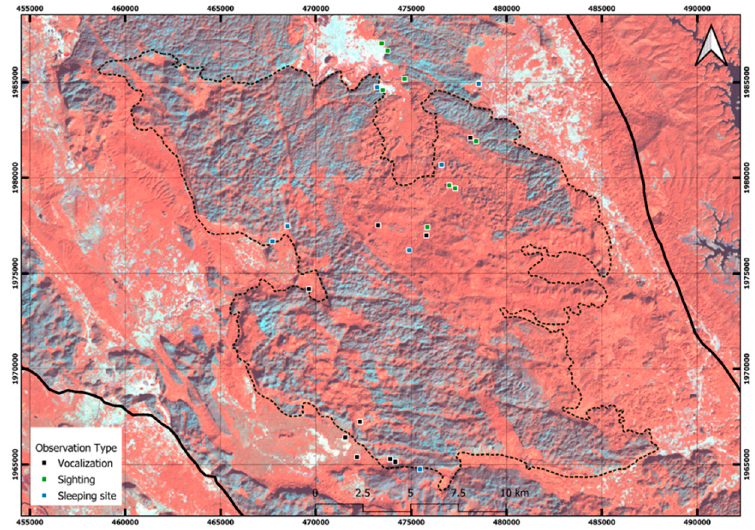
Table 3. Laotian langur encountered on trails walked in each sector. In this table, we include both the directly observed groups and those recorded by vocalizations during our surveys. For these latter groups, it was impossible to determine the size, sex or age of their members.